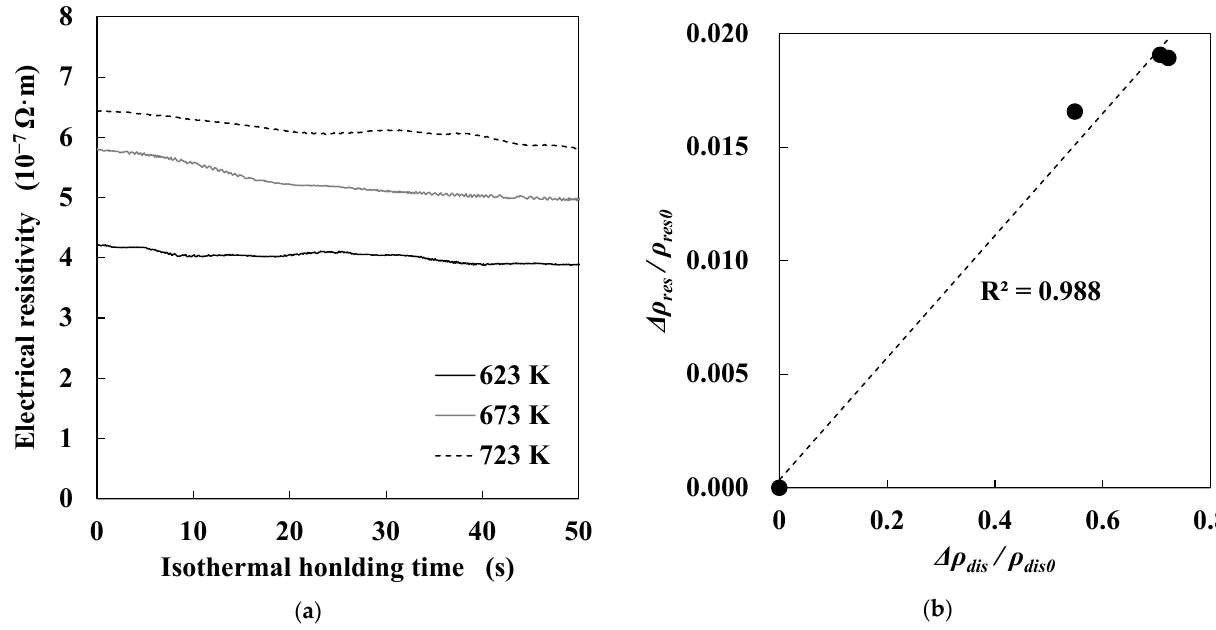
Figure 6. ( a ) Changes in electrical resistivity during isothermal holding at each temperature; ( b ) relationship between decreasing rates of electrical resistivity and dislocation density due to annealing.